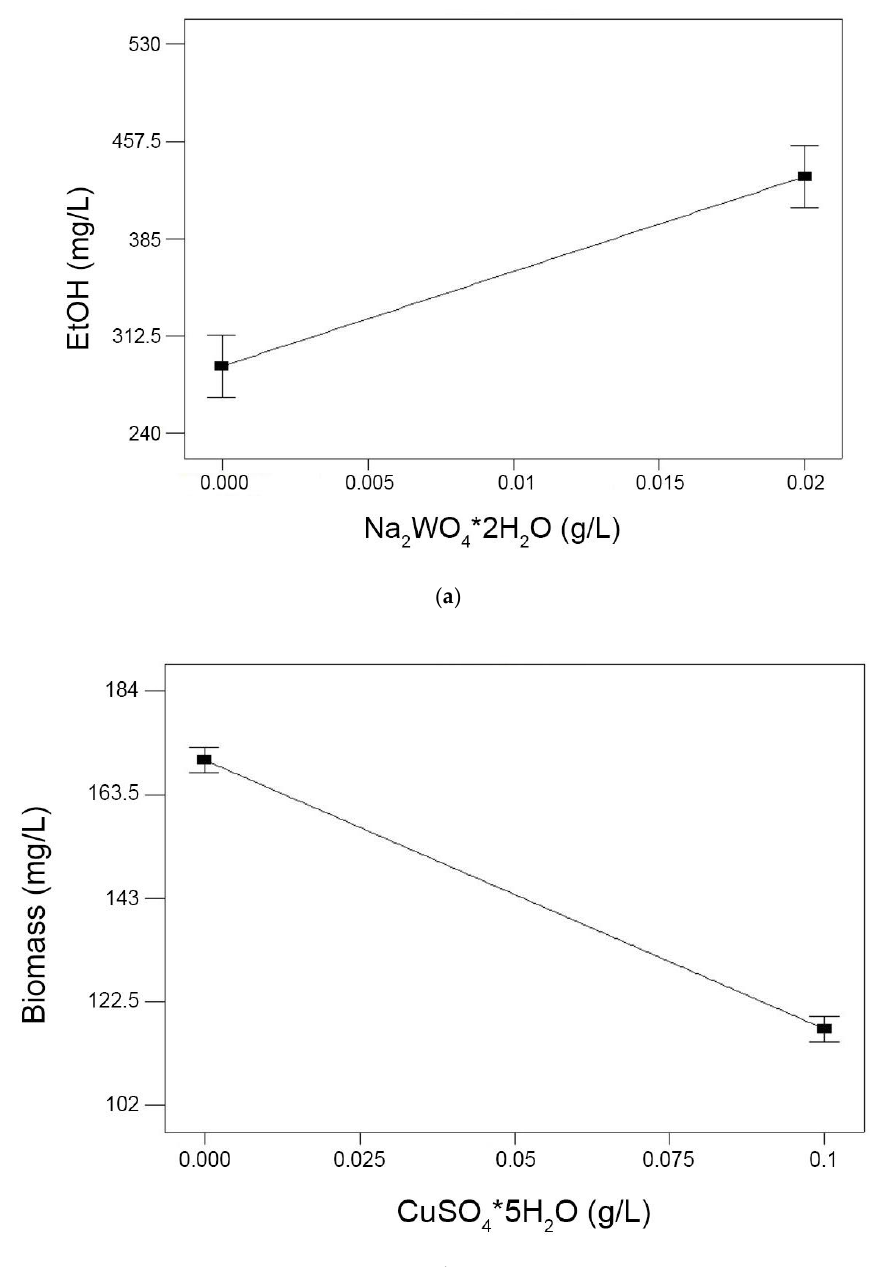
Figure 5. Main effects plot for ( a ) ethanol (mg/L) and ( b ) biomass (mg/L) production.